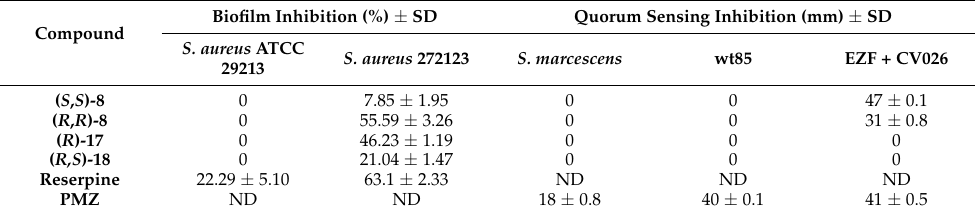
Table 3. Biofilm and quorum sensing inhibition of the chiral xanthones